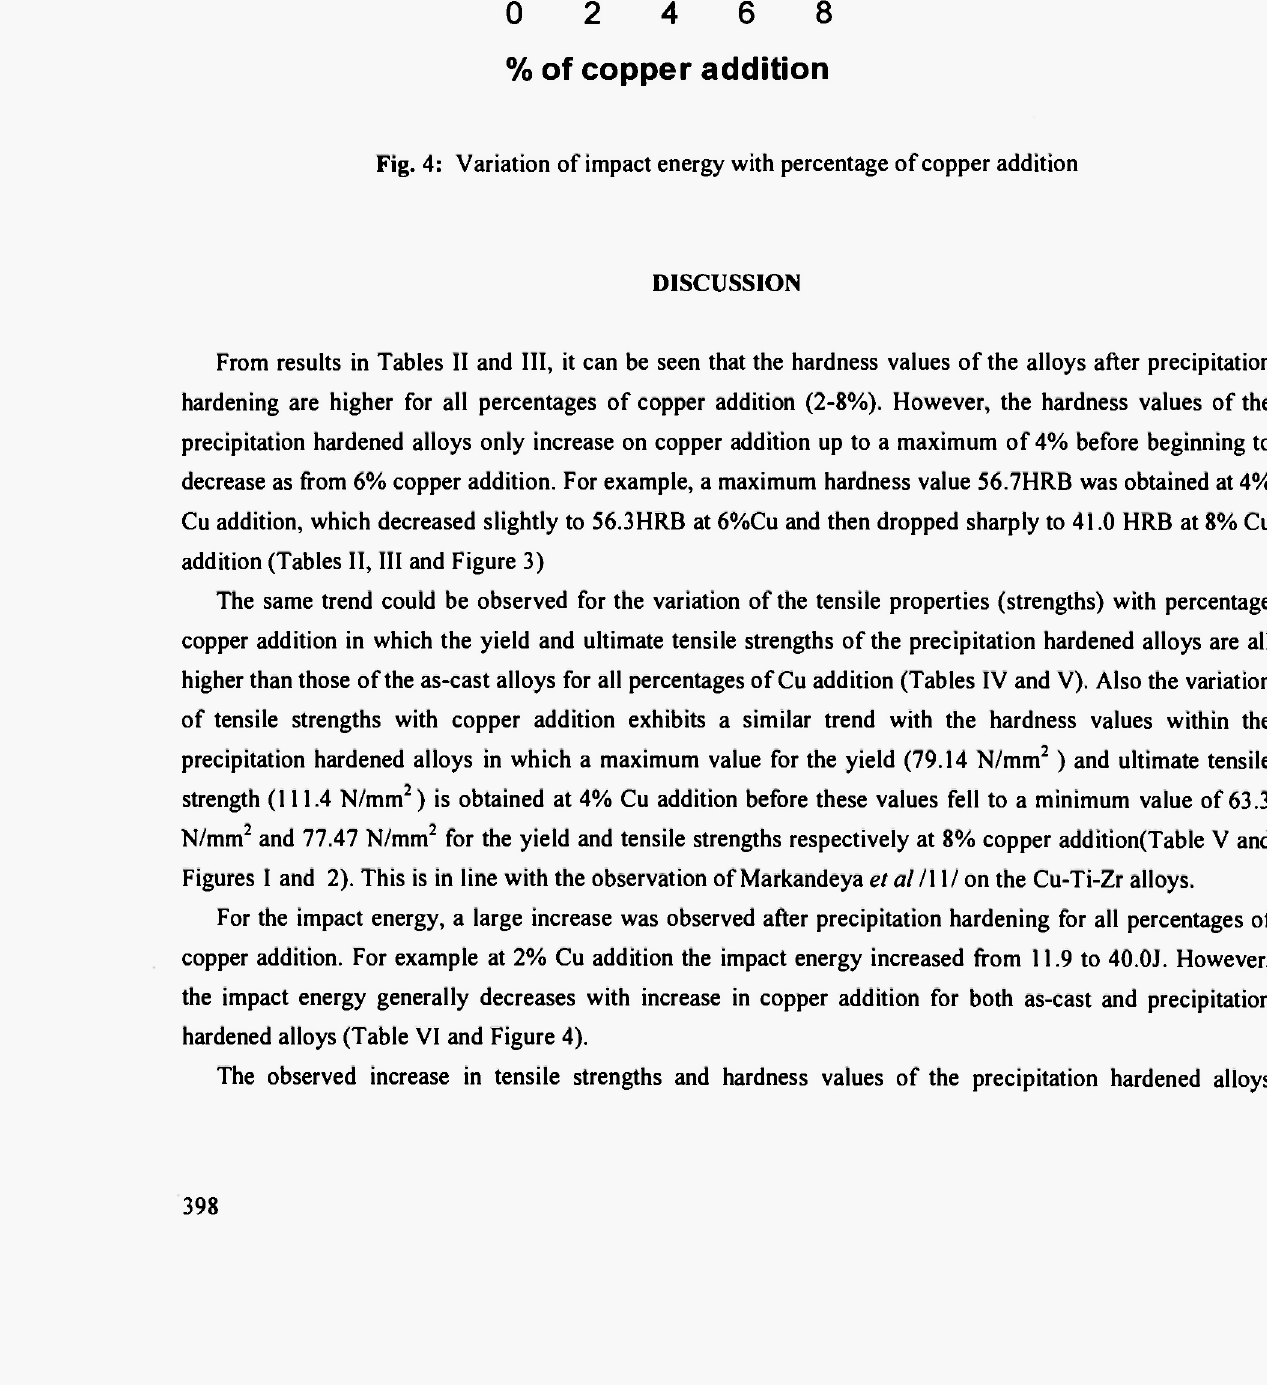
Fig. 4: Variation of impact energy with percentage of copper addition